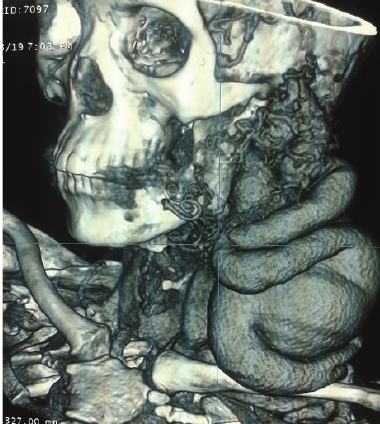
Figure 2: CT scan image of the cervical AVM. Anterolateral view showing connections with carotid, jugular, and subclavian.